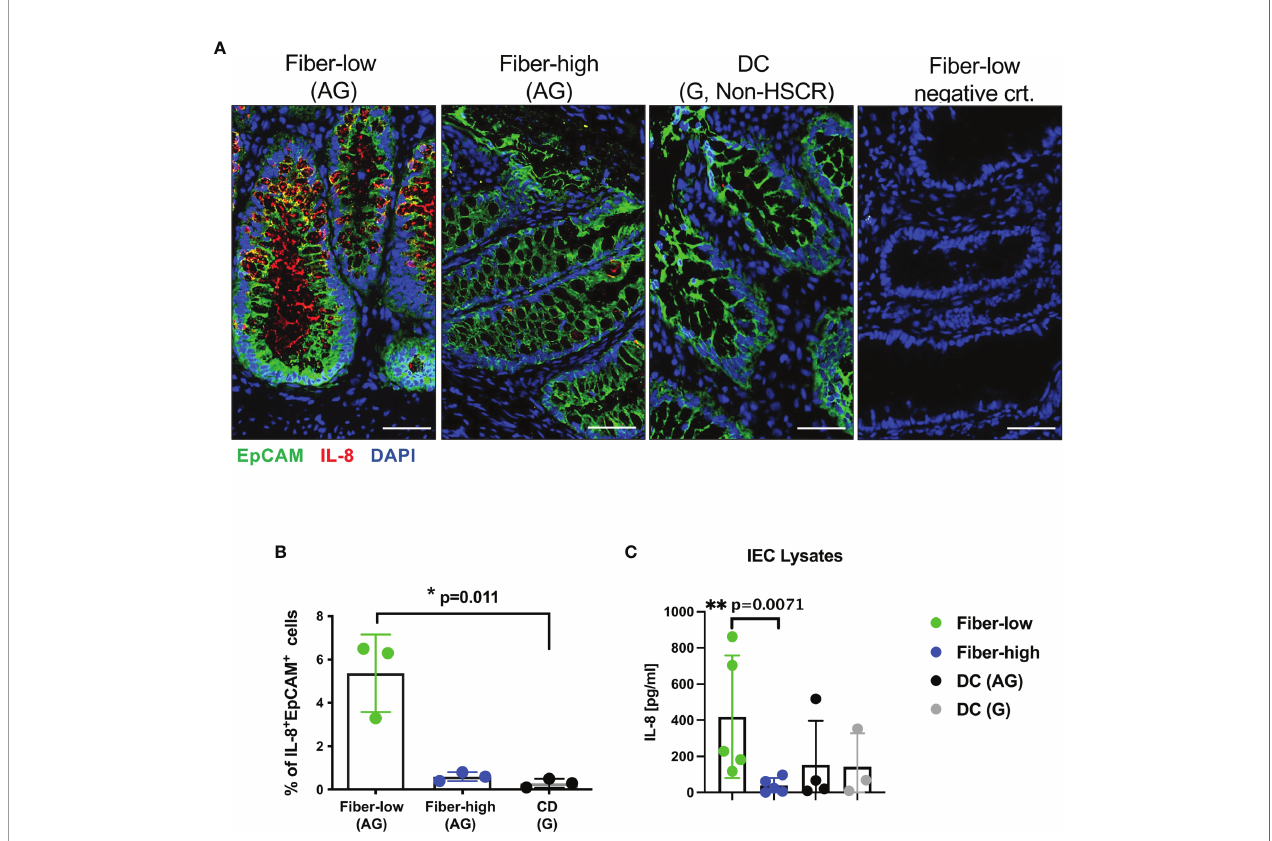
FIGURE 3 | IL-8 protein expression in patient-derived IEC. Immuno fl uorescence (5µm cryosections) of rectosigmoid using human antibodies against EpCAM (Alexa488, green) and IL-8 (Alexa555, red). DAPI (blue) shows cell nuclei. Secondary antibody goat anti-mouse IgG1 Alexa 555 was used as the negative control. Scale bars 50µm (A) . Quanti fi cation of IL-8 using Cellpro fi ler-3.1.9 software. IL-8 expression in EpCAM + IEC (n=3) was quanti fi ed in 4 to 8 epithelial regions (on average 1500 IEC) per patient from fi ber-low and fi ber-high rectosigmoid tissue. Frequencies of IL-8 + EpCam + cells were shown as the percentage of total EpCam + epithelial cells. (B) . Patient-derived IEC were lysed, and IL-8 was determined using human IL-8 ELISA Ready-SET-Go Kit. (C) Signi fi cance was determined using the Kruskal-Wallis test (*p ≤ 0.05, **p ≤ 0.01). Scatter plots show means ± SEM. AG, aganglionic; G, ganglionic; DC, descending